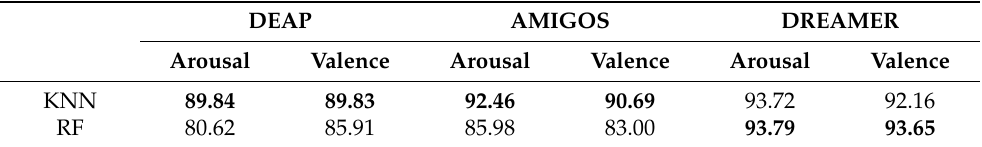
Table 8. Accuracy values (%) for arousal and valence binary classification. Values in bold represent the best results for each column.